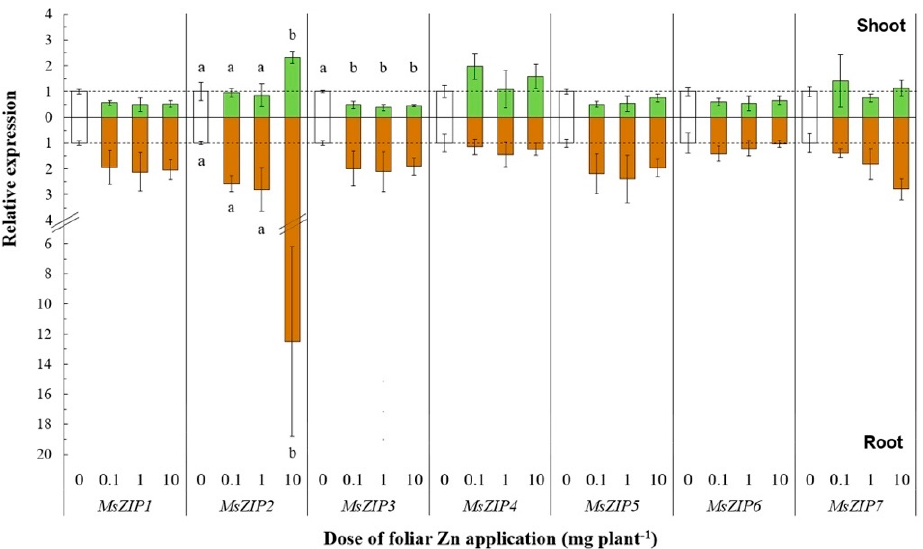
Figure 3. Relative expression of transmembrane Zn transporter genes after leaf Zn application to alfalfa. The Zn doses were 0, 0.1, 1, or 10 mg Zn plant − 1 . Means ± standard error of three replicates are shown. The expression levels were calculated relative to reference genes ( MsACT- 101 for shoot and MsEF1- α for root) and to the control (0 mg Zn plant − 1 ). The broken line denotes the threshold between up- and downregulation relative to the control. Differences in the expressions of each gene after different Zn doses were tested separately for shoot and root by one-way analysis of variance. Different letters denote significant differences among Zn doses, according to Tukey-B test ( p < 0.05).